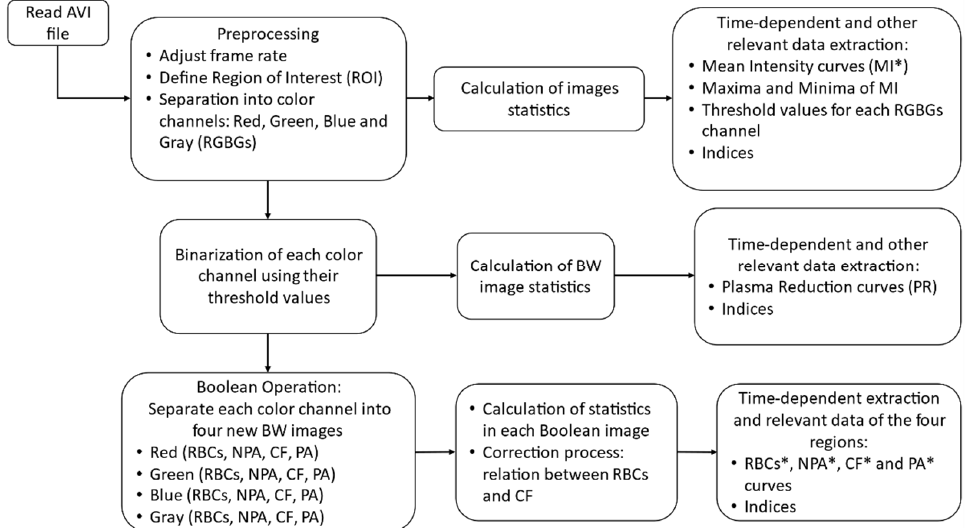
Figure 3. Flowchart of the proposed algorithms showing the three stages.